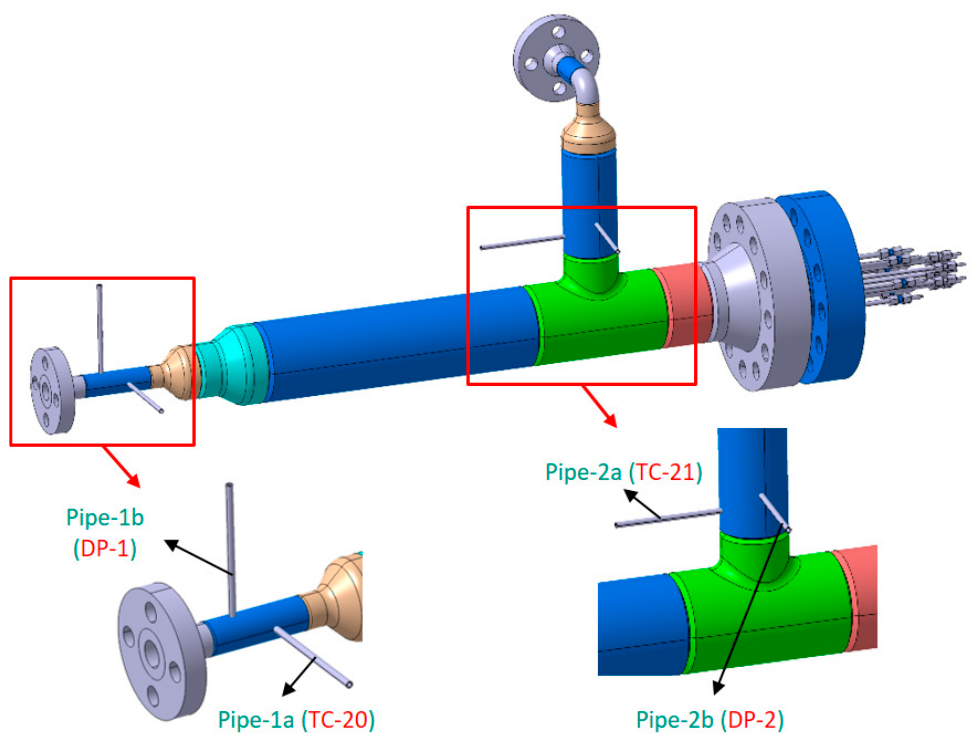
Figure 6. Thermocouples and pressure sensors upstream and downstream of test section.